Question: Looking at the figure, what chart type is it?
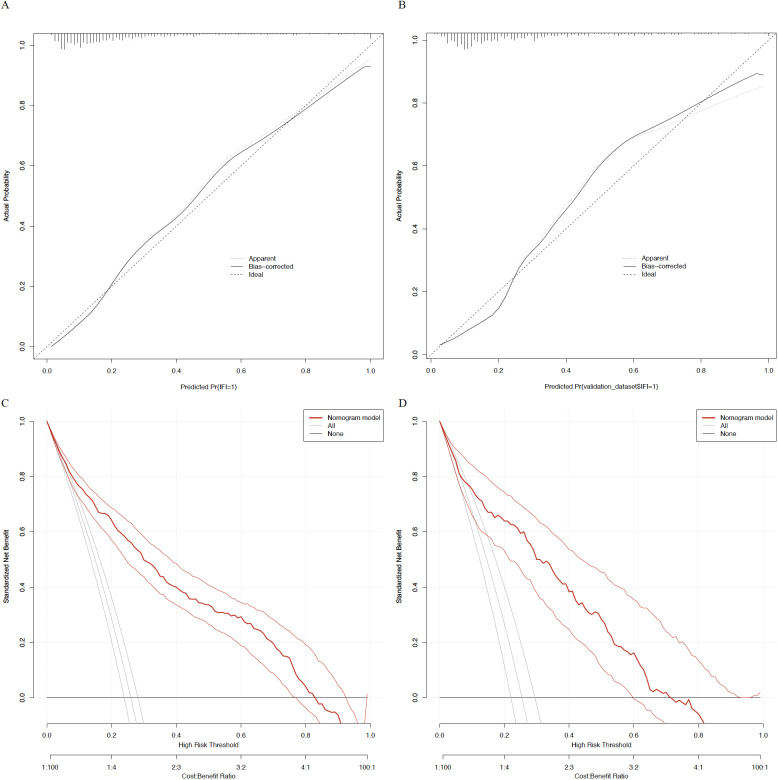
Answer: line